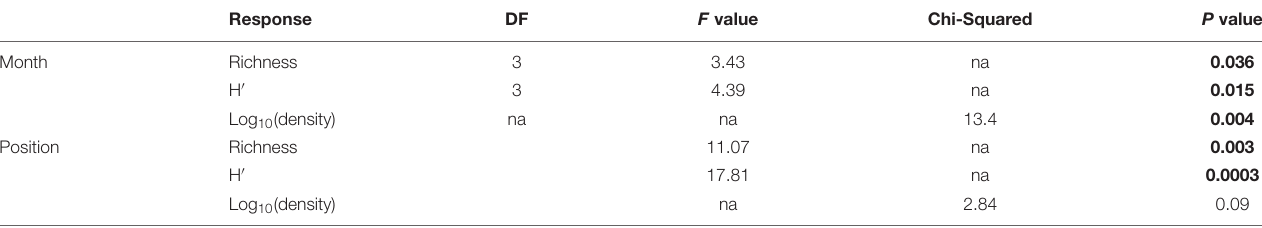
TABLE 1 | Results of two-way ANOVAs (richness, H (cid:48) ) and Kruskal–Wallis test [log 10 (density)] against cruise and spatial position. Response DF F value Chi-Squared P value